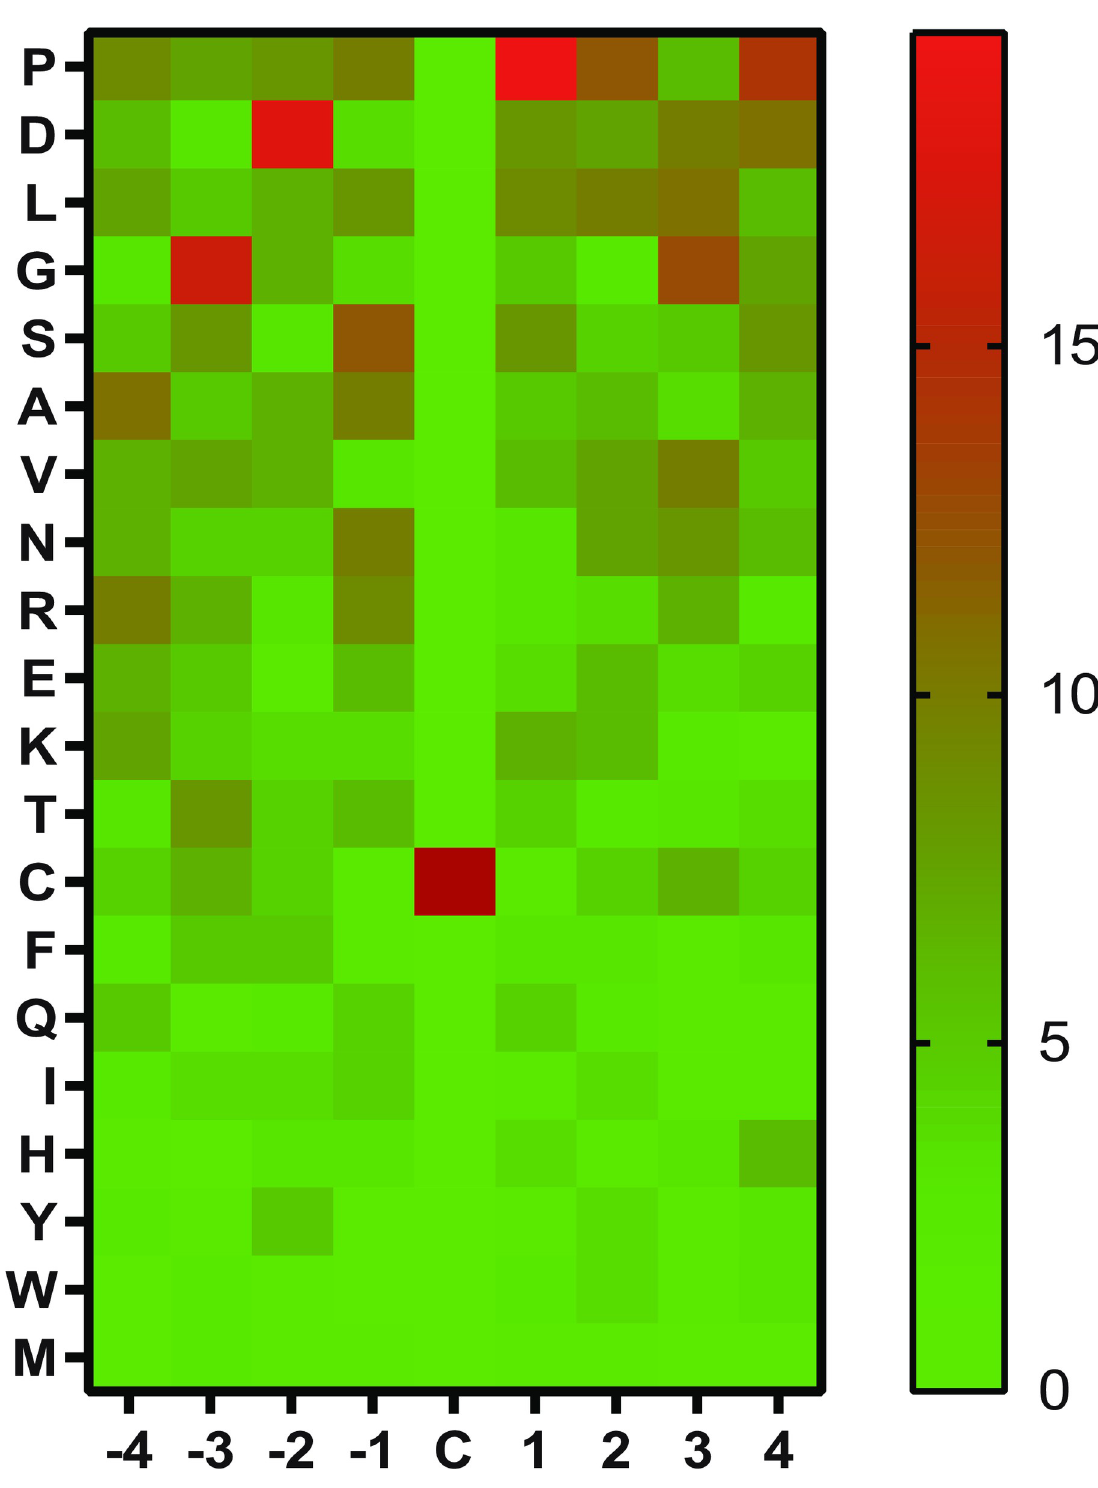
Fig 8. Sequences that do not react with CAM-cys antibodies. All cysteine residues from proteins that were found to be unreactive to both 4E7 and 52H11 after IAM treatment were analysed as follows: The four residues surrounding each side of the cysteines were arrayed for each of the eight positions relative to the cysteine. The relative frequency of each amino acid was then determined (percentage of all residues) and displayed by amino acid by position in a heat map. The most common amino acids at each position are listed at the top of the